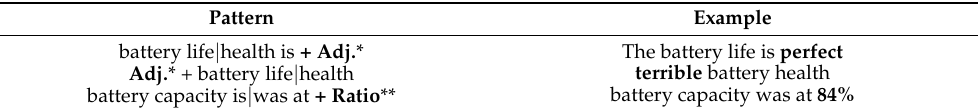
Table 2. Pattern examples of batteries. Pattern